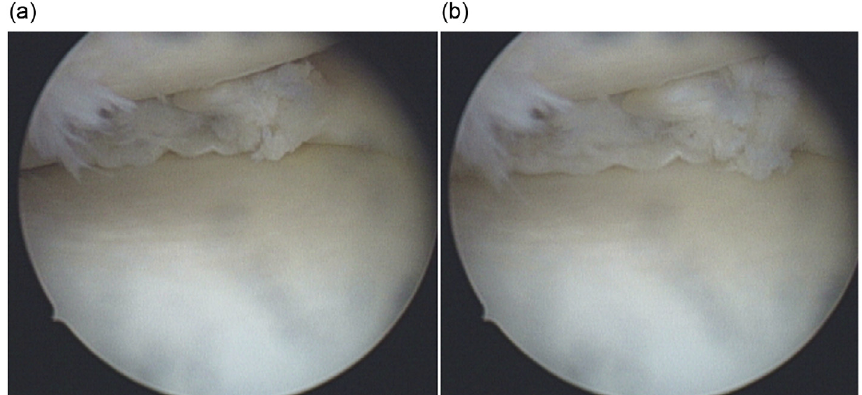
Figure 2. (a, b) Arthroscopic image of left knee showing the position and tear of posterior horn of medial meniscus with and without the